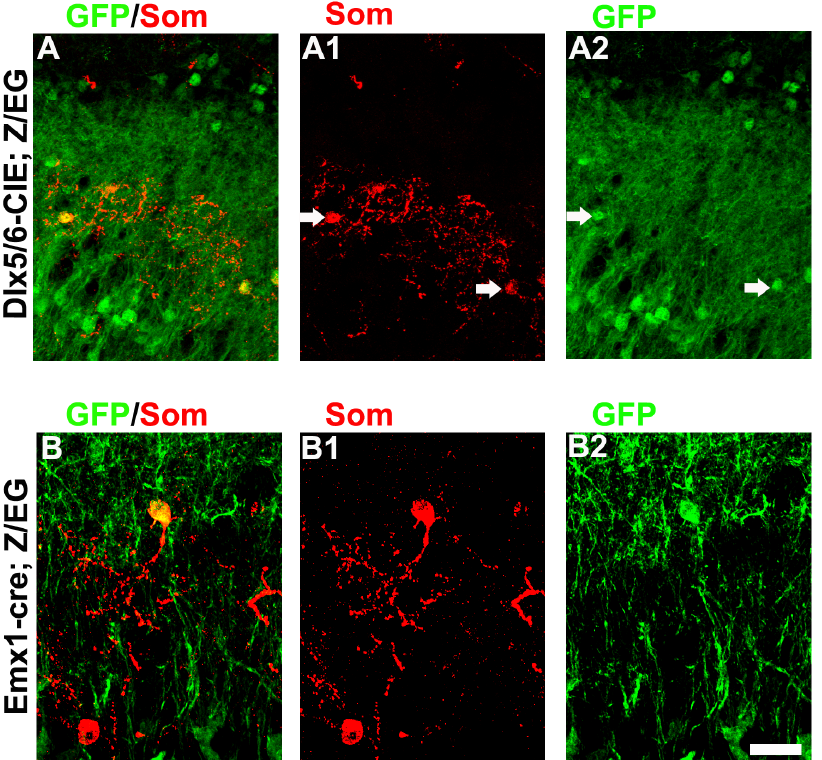
Figure 4. Dlx5/6 and Emx1 lineage contribute to the Som + interneurons in the OB. (A) Representative images of the GFP + cells that express Som in the OB of adult Dlx5/6-CIE; Z/EG mice. (B) Representative images of the GFP + cells that express Som in the OB of adult Emx1-Cre; Z/EG mice. Scale bars: 50 m m (in B2 applies to A and B).